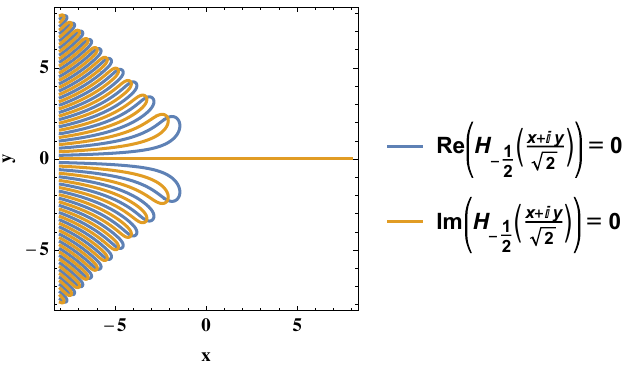
(cid:16) (cid:17) z p (cid:0) 1 2 2